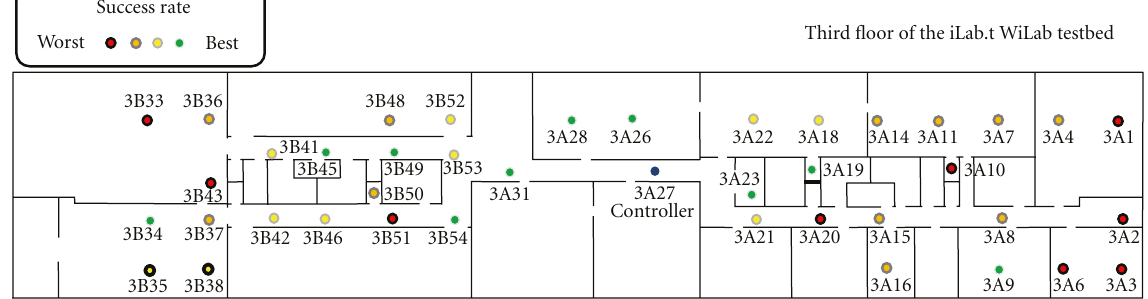
Figure 13: Spatial distribution of the individual success rate in the Castalia simulator. 4 categories: green = best, yellow, orange, and red (least good). The blue nodes are not